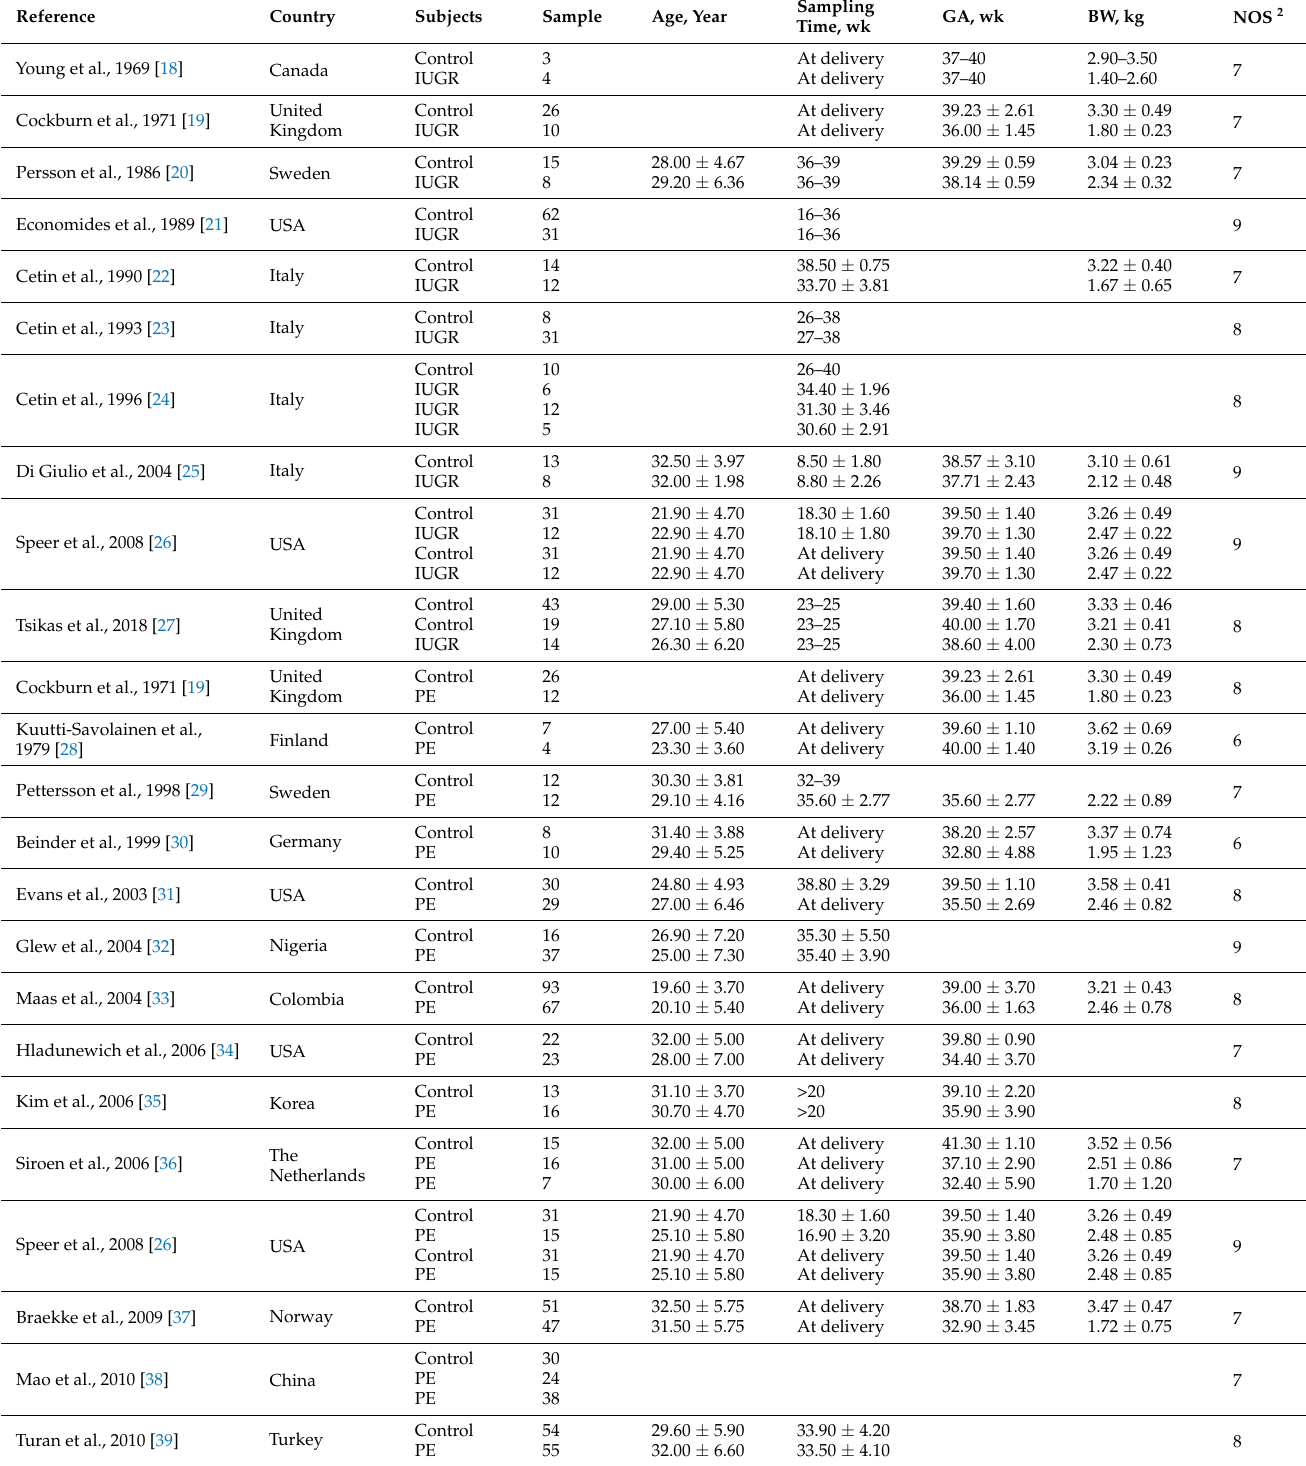
Table 1. Characteristics of the included case-control studies regarding maternal arginine concentra- tions in different pregnancy complications 1